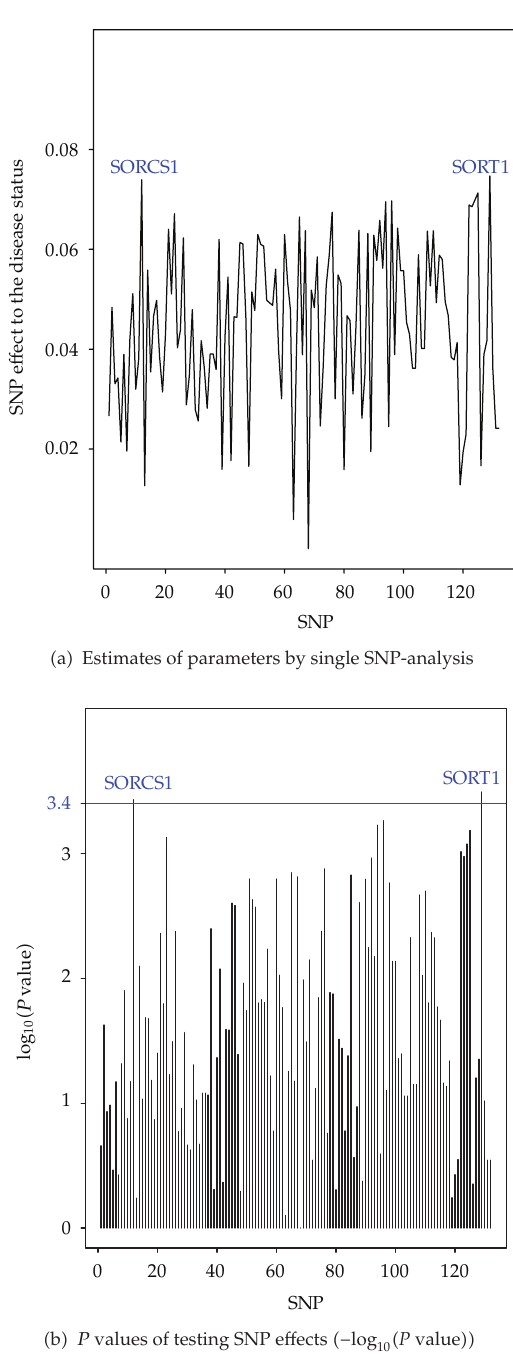
Figure 4: Analysis of genes for IGT/IFG through IFG pathway (cid:2) Data Set D2 (cid:3) with single